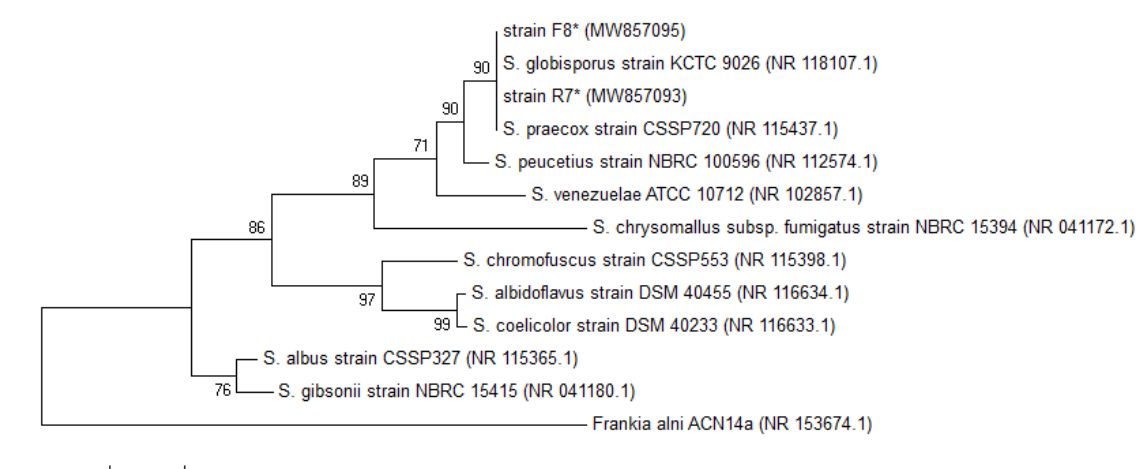
Figure 4. Neighbor joining phylogenetic tree based on 16S rRNA sequences of Streptomyces praecox strain R7 and Streptomyces globisporus strain F8. Frankia alni (Woronin) ACN14a was used as an outgroup. The accession numbers of the sequences are given in parentheses. Bootstrap values are based on 1000 resampling. Bar indicates 0.01 substitutions per nucleotide position. *actinomycetes isolates used in the present study.